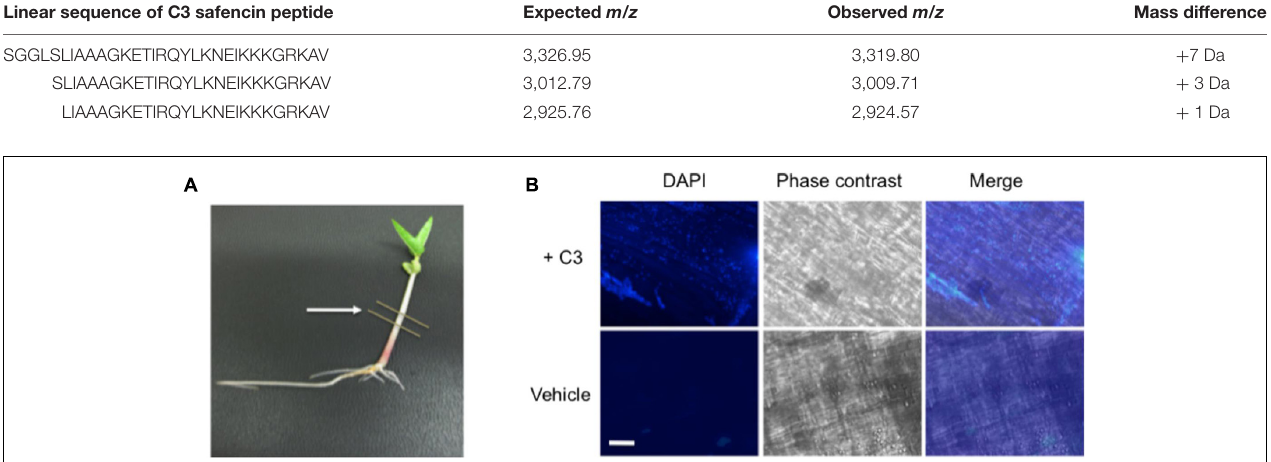
TABLE 1 | MALDI-TOF m/z data of HPLC purified antimicrobial peptide (AMP) after leucine aminopeptidase digestion. Linear sequence of C3 safencin peptide